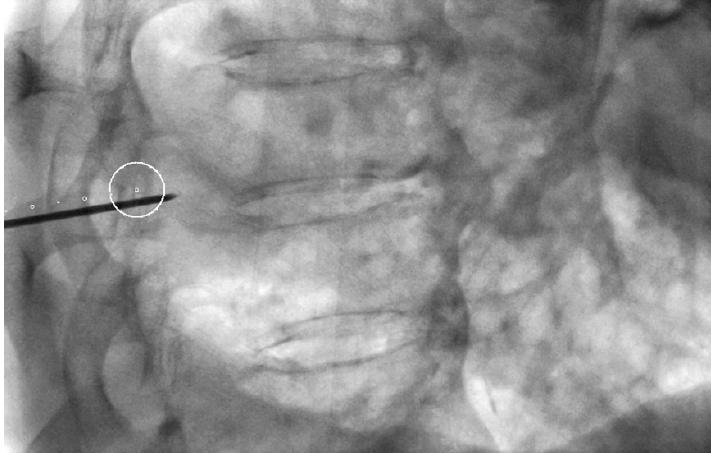
Figure 2. Lateral oblique projection on fluoroscopy. Virtual marks indicate the puncture route in caudal cranial direction and the circle the target. The circle is the point where the needle will reach.